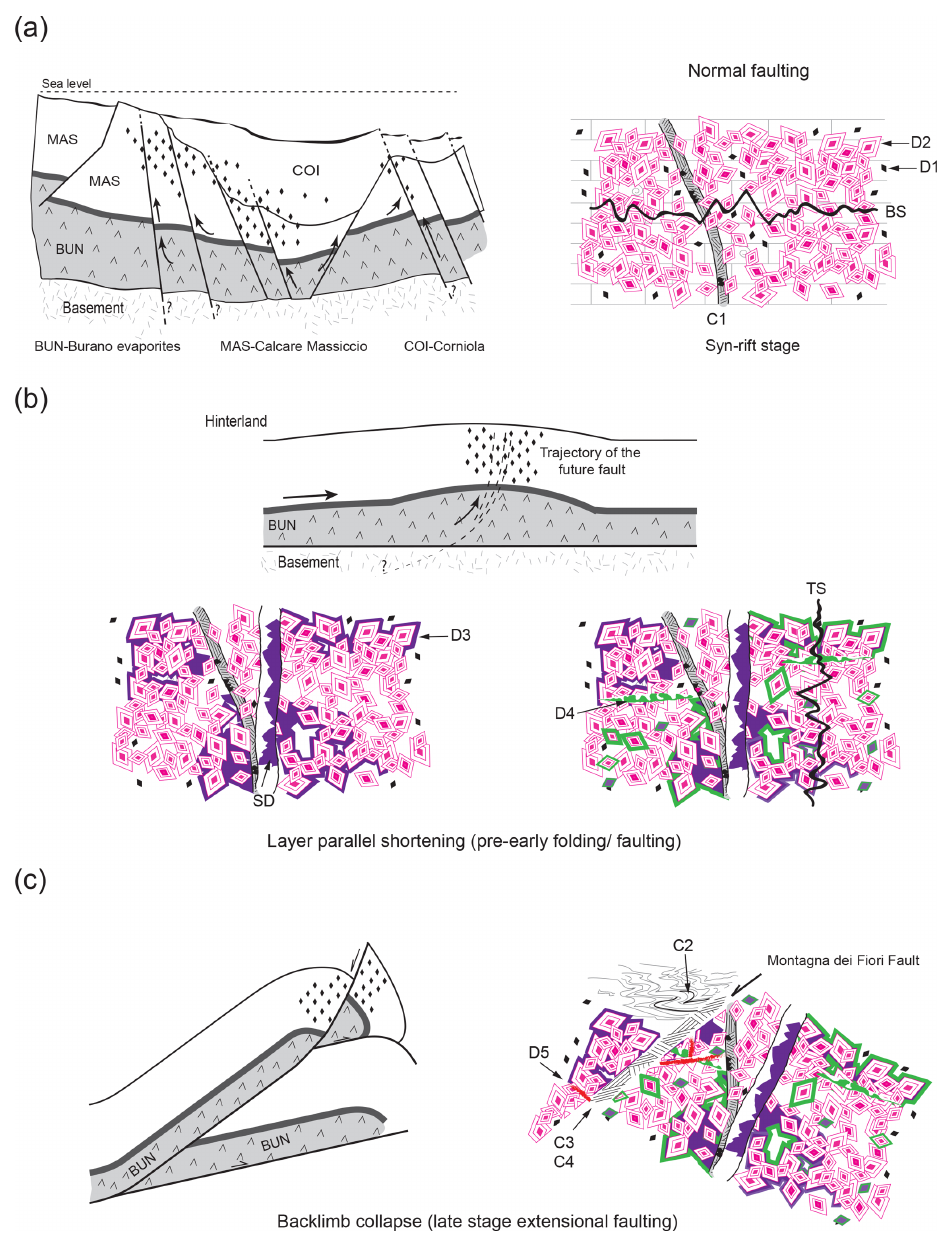
Figure 15. Sketch showing the successive fault-related diagenetic phases of most importantly dolomitization, recorded in the carbonate succession exposed at the core of the Montagna dei Fiori Anticline (not scaled). Different diagenetic phases are indicated with different colors. (a) The first dolomitization event is pre-orogenic (syn-rift), triggered from the fluids channelized along Jurassic ∼ E–W- and ∼ N–S- striking extensional faults. This event occurred during burial compaction and development of bed-parallel stylolites (BS). It is represented by scattered dolomite rhombs (D1) followed by calcite cementation (C1). The dolomitization continued with precipitation of larger crystals of D2. (b) Second dolomitization event: syn-orogenic (early folding/faulting) dolomitization from fluids that migrated from more internal regions of the thrust belt and were channelized along the basal detachment level into the fold core. This dolomitization event presents matrix replacive and cements displaying infrequent saddle outlines (SD) in pore spaces within bed-parallel veins and shear fractures. These dolostones postdate compaction but are affected by bed-perpendicular stylolites (TS) generated by horizontal to subhorizontal layer-parallel shortening related to the growth of the Montagna dei Fiori Anticline. (c) Extensional collapse of the anticline and development of the Montagna dei Fiori Fault followed by buttressing of the Scaglia against Calcare Massiccio and Corniola formations during positive inversion induced by continuing underthrusting at depth. Precipitation of D5 in microveins and cements in breccia zones, followed by late-stage calcite cementation in the Montagna dei Fiori Fault damage zone (C2, C3, and